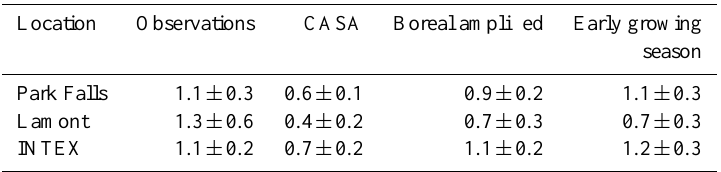
Table 2. Estimated meridional gradient [ppbkm − 1 ] in h CO 2 i during the Northern Hemisphere summer growing season determined from TCCON sites and in free tropospheric [CO 2 ] from INTEX-NA data compared to AM2 simulations.